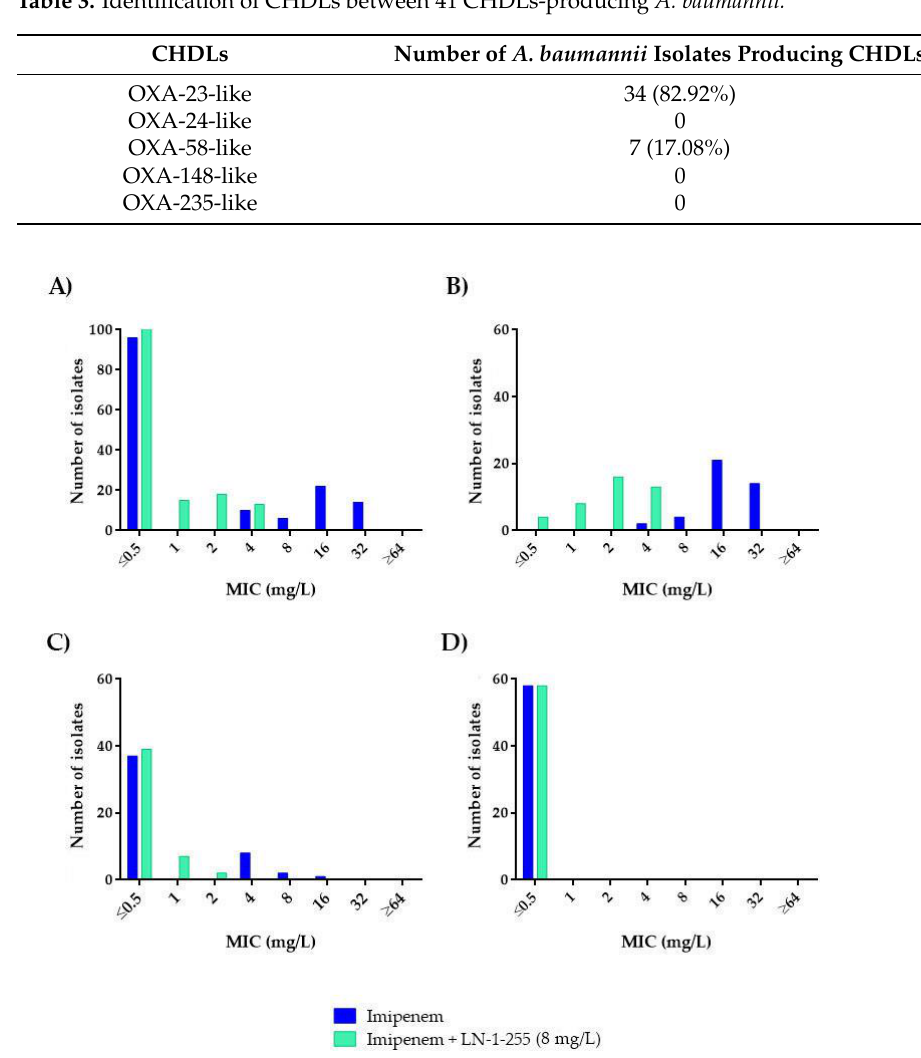
Figure 2. Comparative analysis of imipenem and imipenem/LN-1-255 MICs (mg/L): ( A ) All isolates ( n = 148), ( B ) CHDL-producing A. baumannii ( n = 41), ( C ) A. baumannii producing only OXA-51-like ( n = 48), and ( D ) non- A. baumannii ( n = 59). Addition of LN-1-255 at a fixed concentration of 8 mg/L decreased the carbapenem resistance rates in all the A. baumannii strains tested (Tables 1 and 2). For the group of acquired CHDL-producing A. baumannii , imipenem and meropenem decreased the resistance rates from 95.1% to 0% and from 100% to 9.8%, respectively, decreasing the MIC 50 and MIC 90 8-fold for imipenem and 8- and ≥ 16-fold for meropenem, and thus indicating strong potentiation of the in vitro activity (Figures 2B and 3B). Importantly,